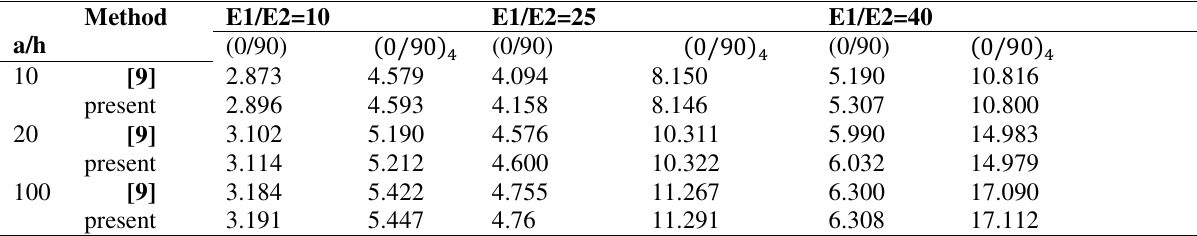
Non-dimensional biaxial buckling load of antisymmetric cross-ply laminates